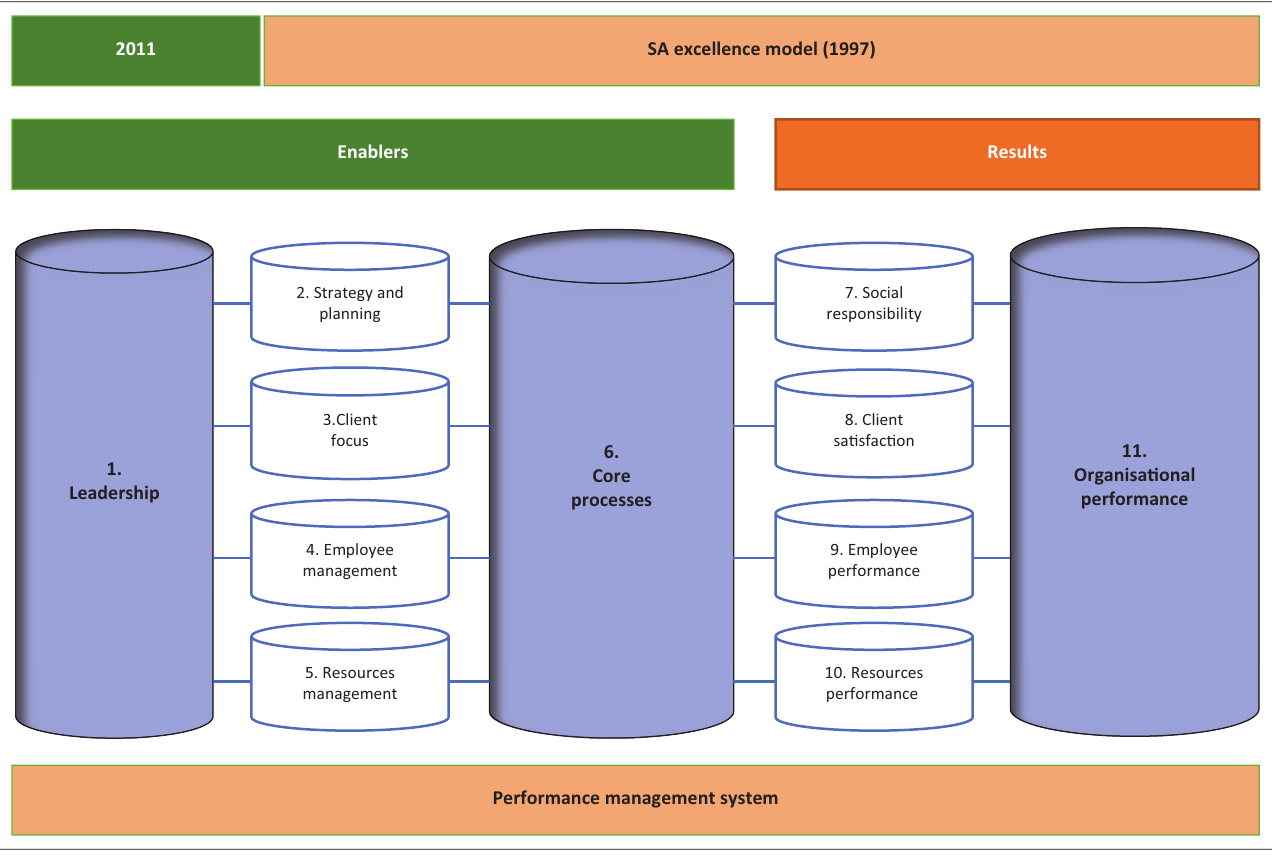
FIGURE 1: The South African Excellence Model.